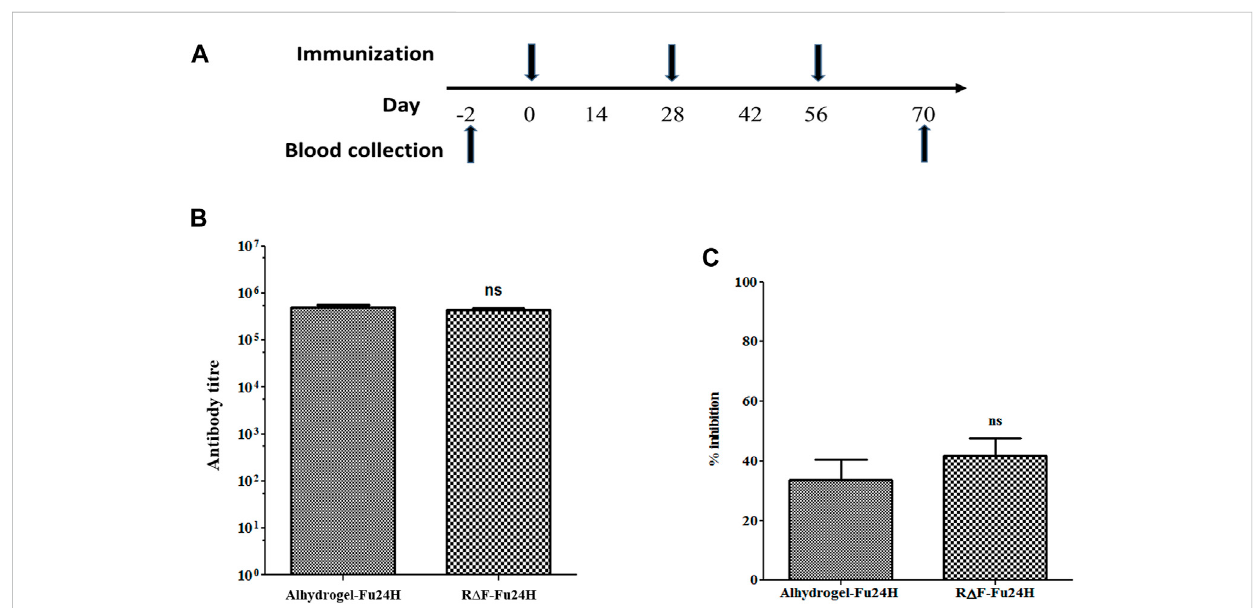
FIGURE 5 (A) A schematic drawing illustrating the immunization schedule for the R Δ F-Fu24H complex and Alhydrogel ® -Fu24H. (B) The end-point titers of